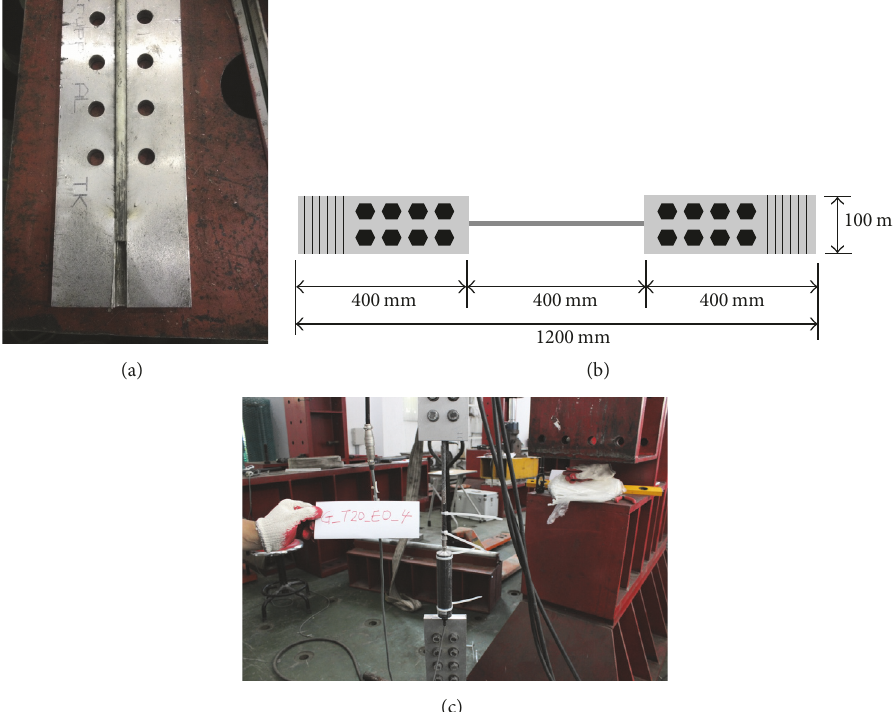
Figure 6: Test-setup assembly: (a) gripping fixture, (b) anchoring detail for tensile test, and (c) installation of LVDT.